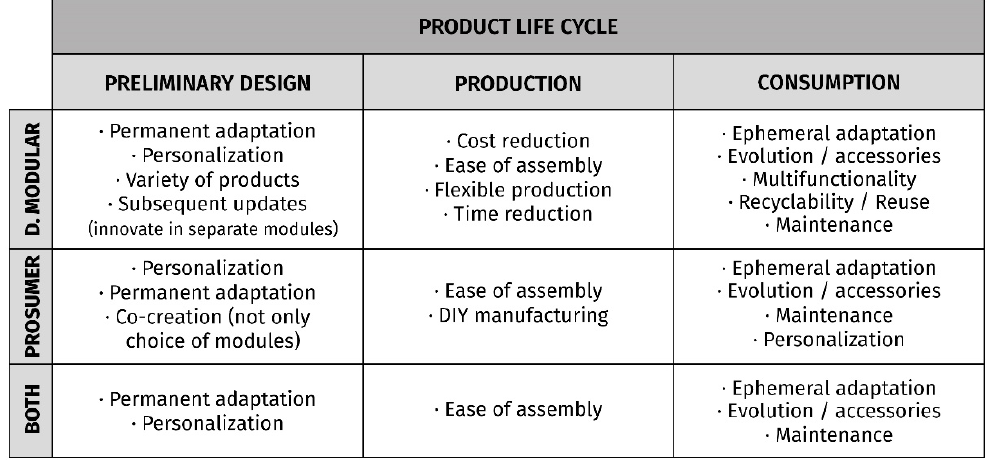
Figure 4. Relationship between modular design and the prosumer field.